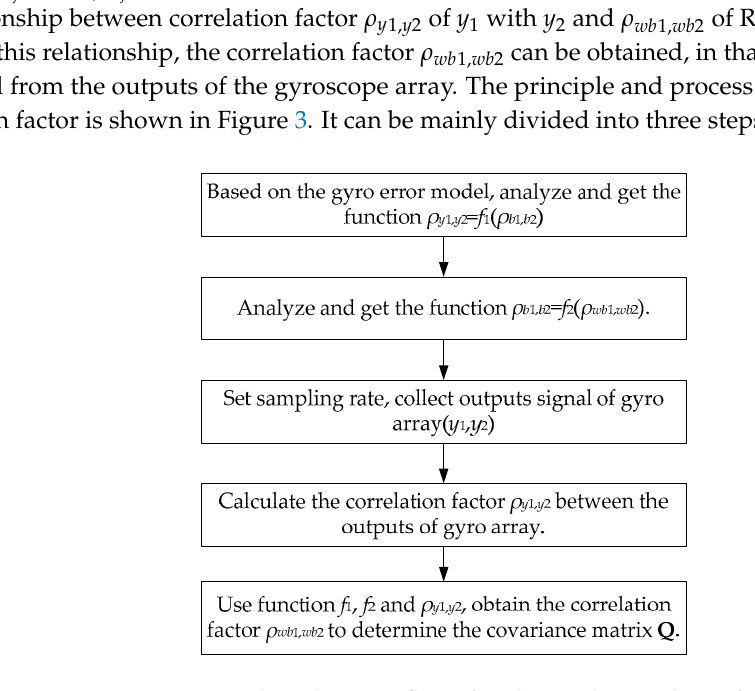
Figure 3. Principle and process flow of analyzing the correlation factor.